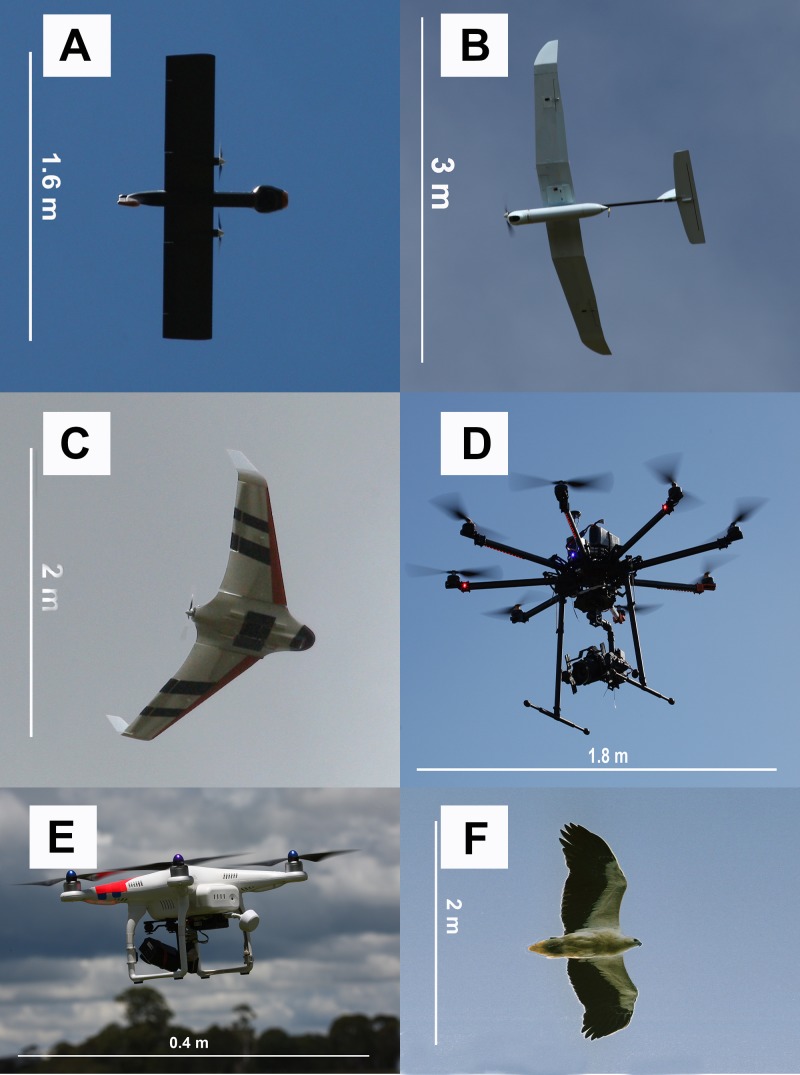
Examples of UAV models with different wing profiles.(A) Avian-P fixed wing UAV, (B) Skylark II fixed wing UAV, (C) Topodrone-100 fixed wing UAV, resembles bird of prey, (D) Kraken-130 multirotor type UAV, (E) Phantom multirotor type UAV, (F) White-bellied sea eagle, a common avian predator active at each study site